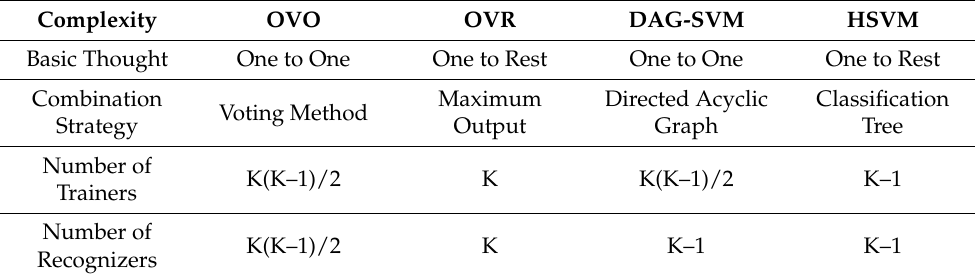
Table 1. The comparison of the training and classification complexity of the multi-classification